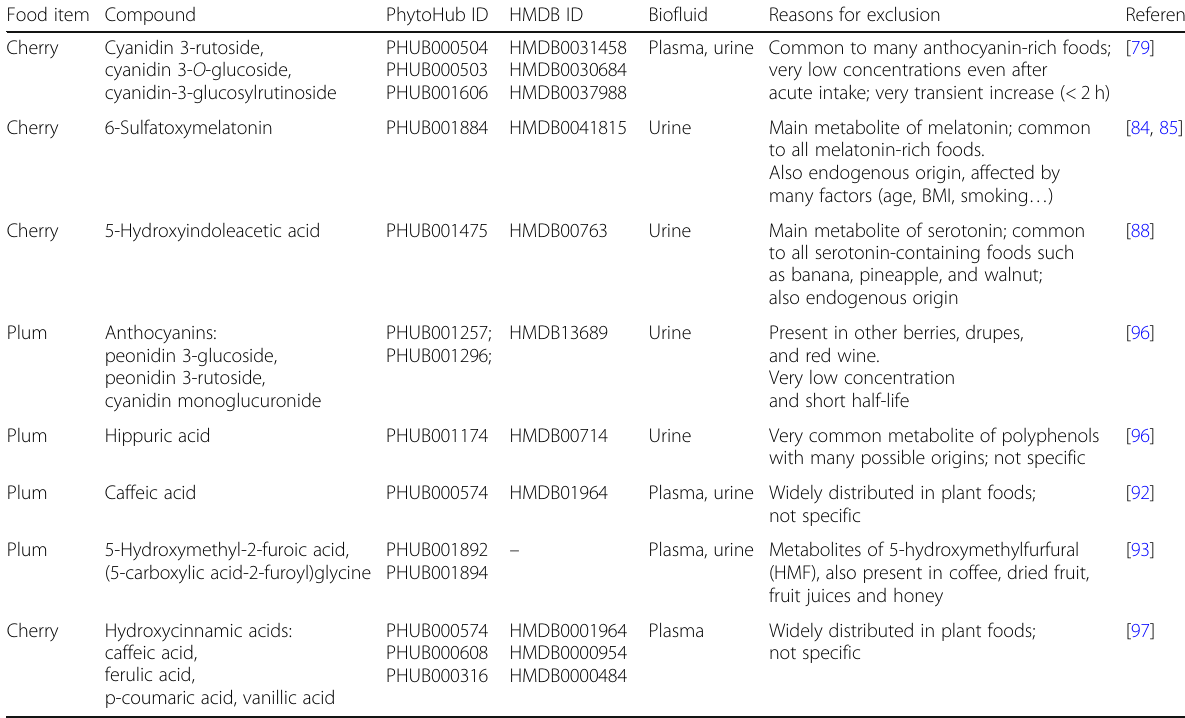
Table 3 List of non-retained compounds for stone fruit Food item